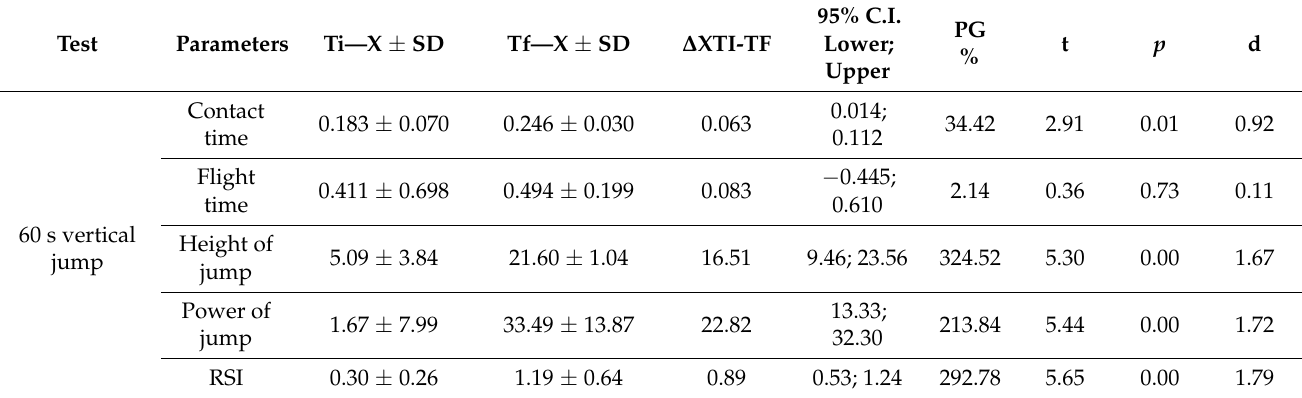
Table 4. Statistical description of the 60 s vertical